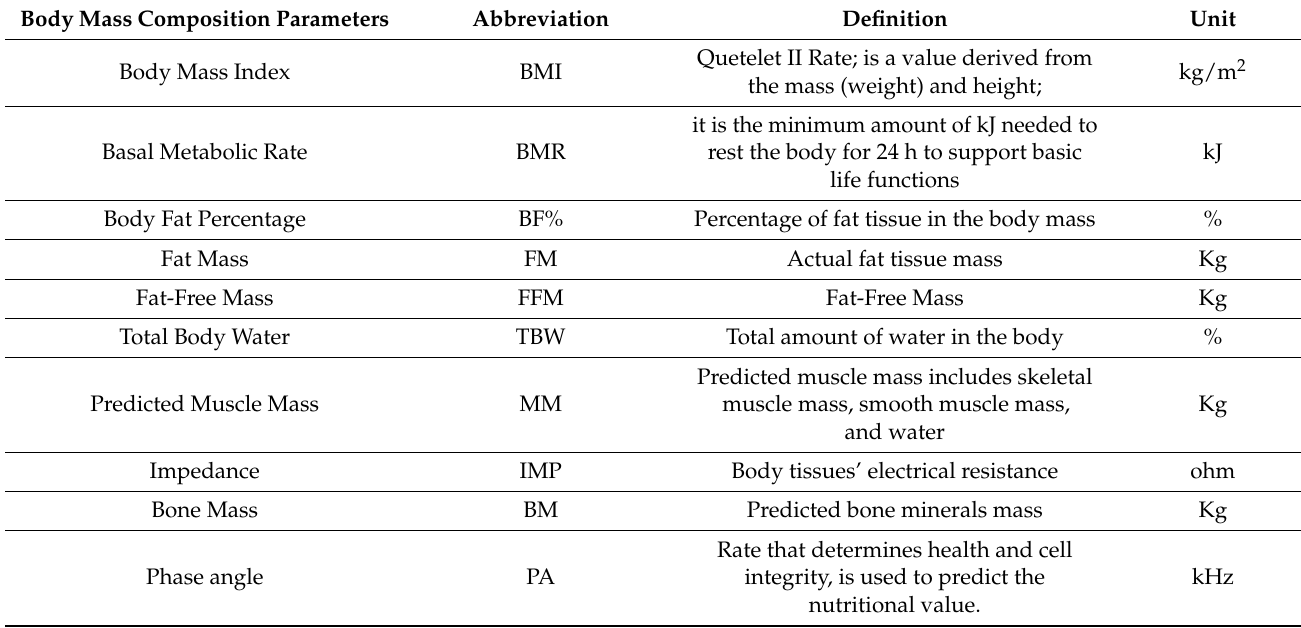
Table 2. Body mass composition parameters (Tanita